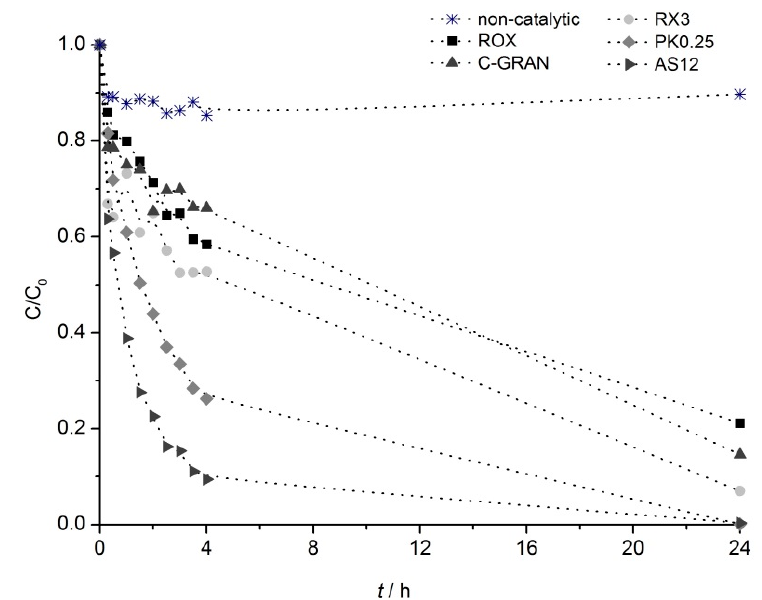
Figure 2. Phenol normalized concentration obtained as a function of time in CWPO runs performed with the commercial AC samples. Experiments performed with [phenol] = 4.5 g L − 1 , [catalyst] = 2.5 g L − 1 , T = 353 K, pH = 3.5 and [H 2 O 2 ] = 25 g L − 1 (stoichiometric amount).